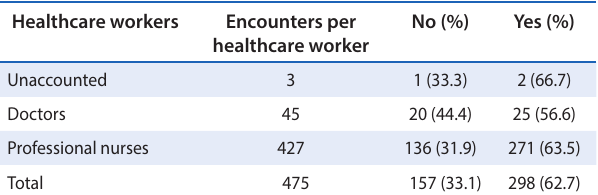
Table 7: Compliance with drug management by healthcare workers Healthcare workers Encounters per healthcare worker